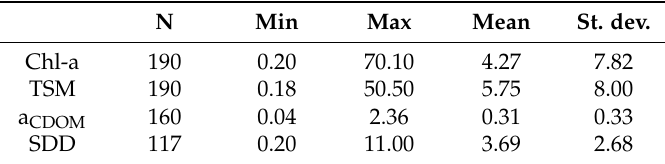
Table 3. Descriptive statistics of in situ measurements for Lake Erie (2004–2012). N is the number